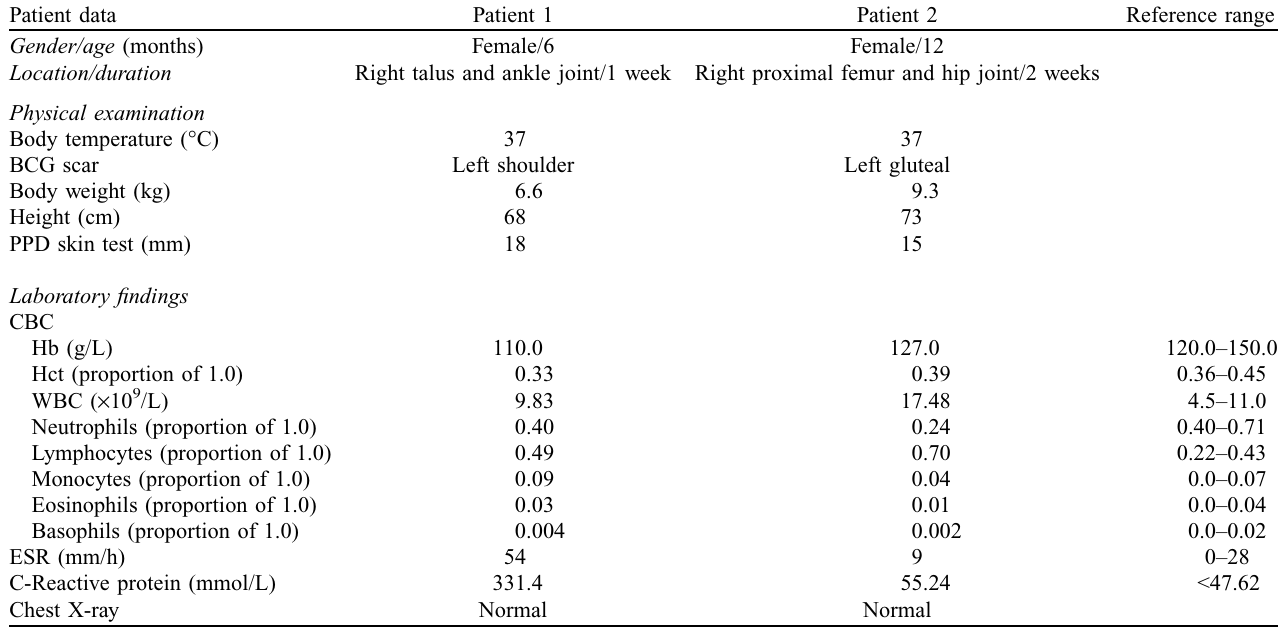
Table 1. Demographic and laboratory data of both patients.